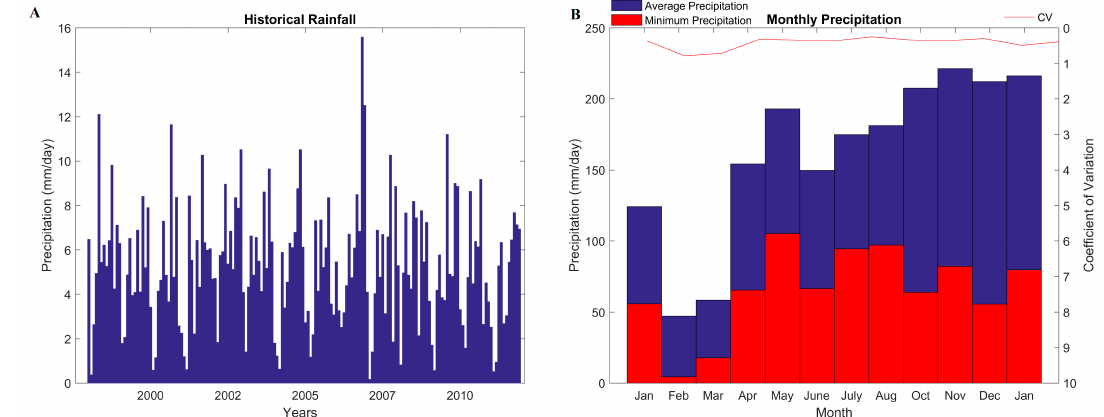
Figure 2. Historical monthly rainfall during 1998–2011 ( A ) and the average and minimum precipitation of each month during 1998–2011 ( B ).